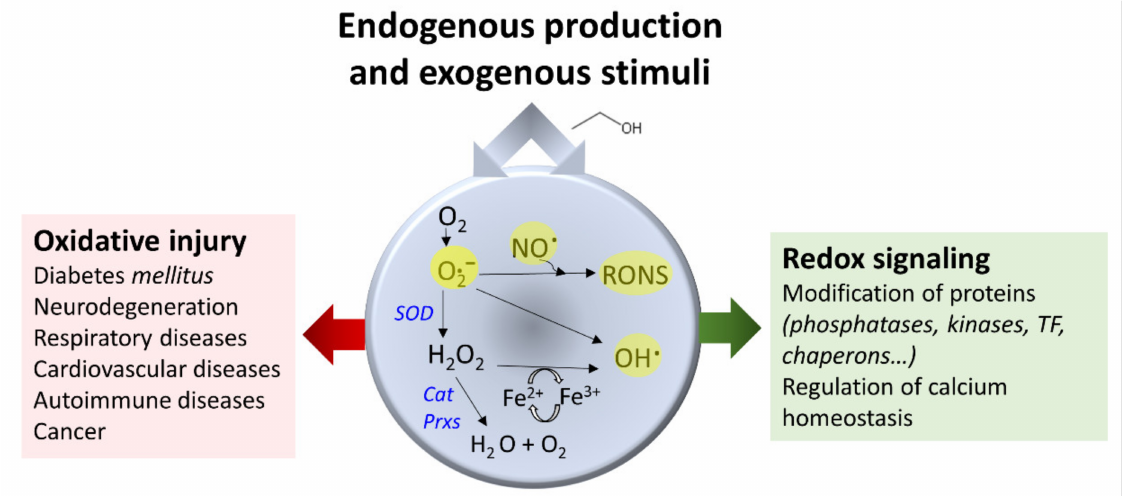
Figure 5. Exogenous agents (for example, ethyl alcohol) and endogenous mechanisms lead to reactive species formation. These species contribute both to physiological signaling and cell damage if the balance breaks. Essential enzymes, including Cat (catalase, EC 1.11.1.21), Prxs (peroxiredoxins, EC 1.11.1.15), and SOD (EC 1.15.1.1), support antioxidant defense activity. TFs, transcription factors; RONS, reactive oxygen and nitrogen species